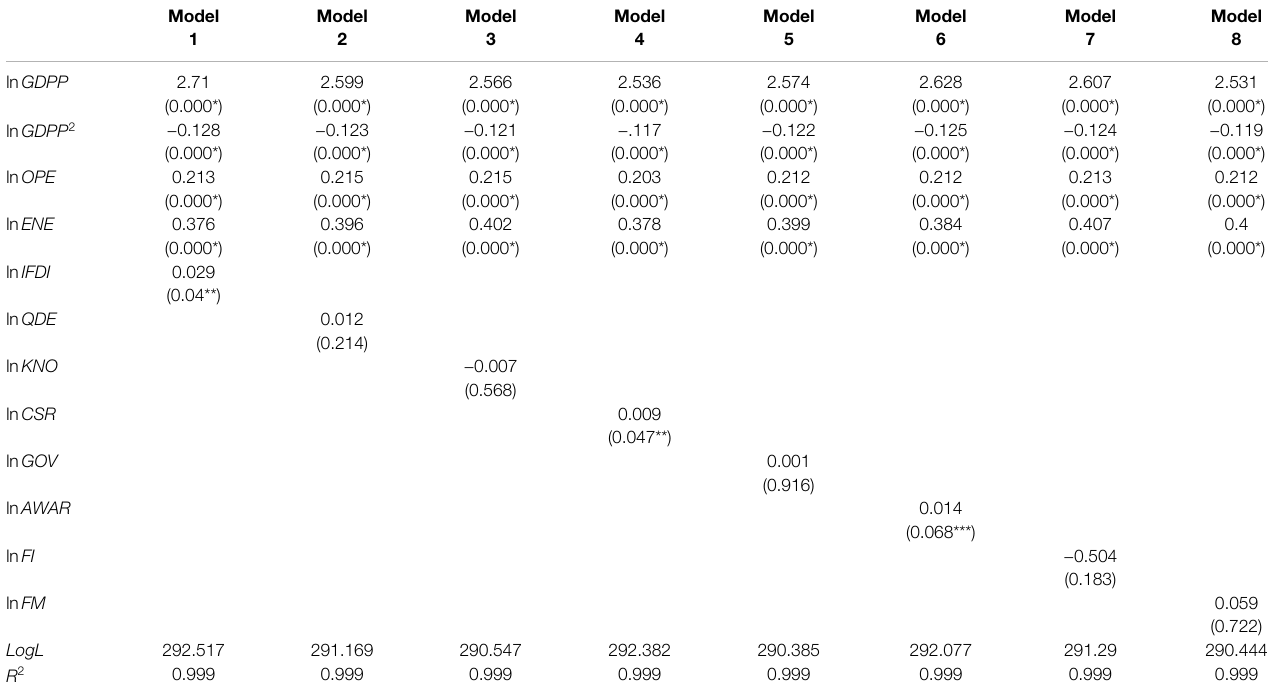
TABLE 6 | Estimation results of different models for Eq. 4